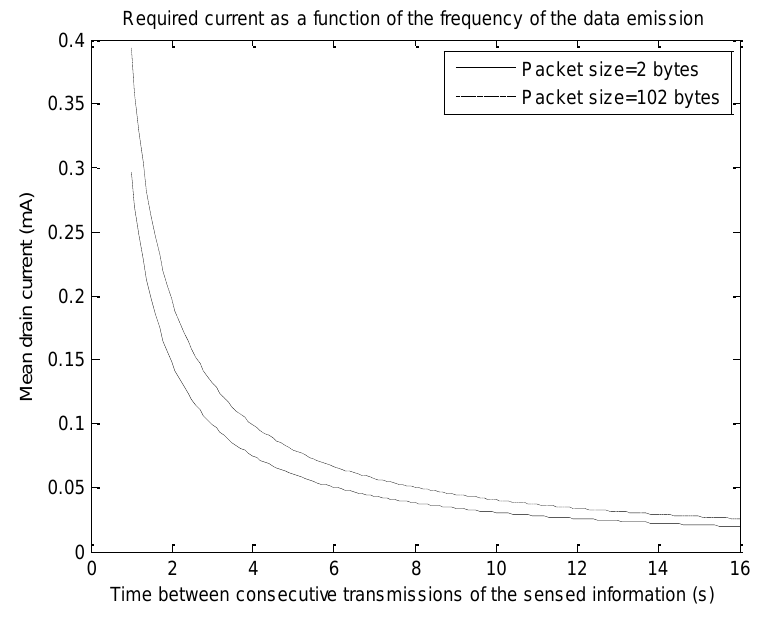
Figure 8. Expected mean drain current (in optimal conditions) of a mote as a function of the frequency of data emission for two different sizes of sensed data (battery capacity is assumed to be 1,200